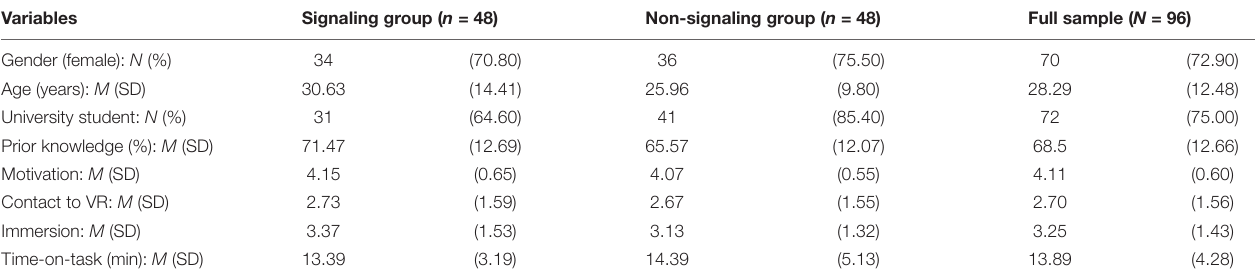
TABLE 1 | Descriptive data of relevant variables, separately for the signaling and non-signaling conditions.